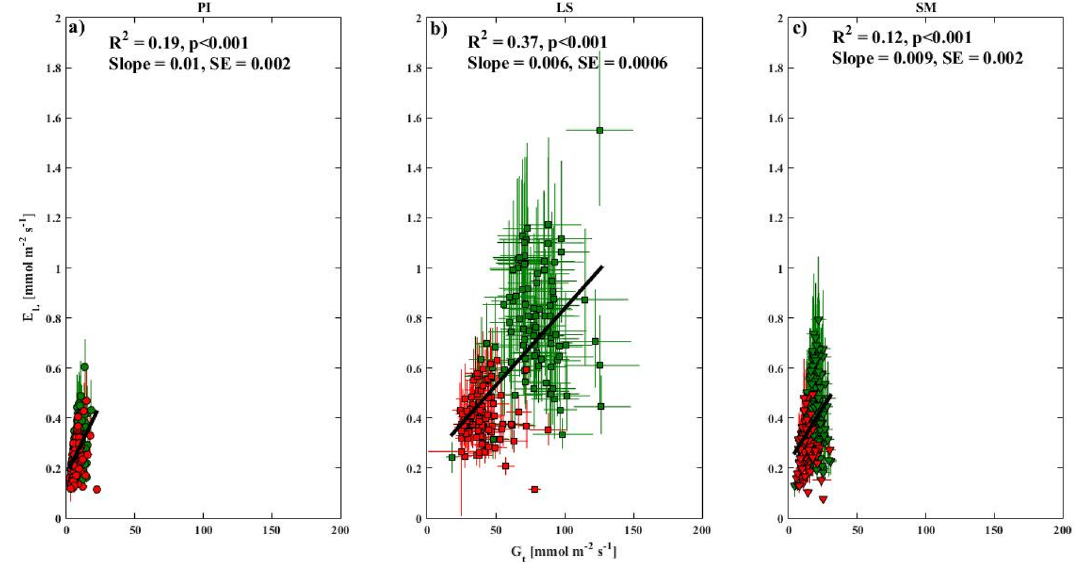
Figure 4. Daily averages of transpiration ( E L ) plotted against canopy conductance ( G t ) for ( a ) P. indicus (PI), ( b ) L. speciosa (LS), and ( c ) S. macrophylla (SM) and seasons plotted in green (wet) and red (dry) symbols. The black lines are linear fits, with the corresponding regression statistics indicated in each panel. This figure was generated using MATLAB version 7.12.0 R2017a (https ://www.mathw orks.com/produ cts/new_produ cts/relea se201 7a.html).